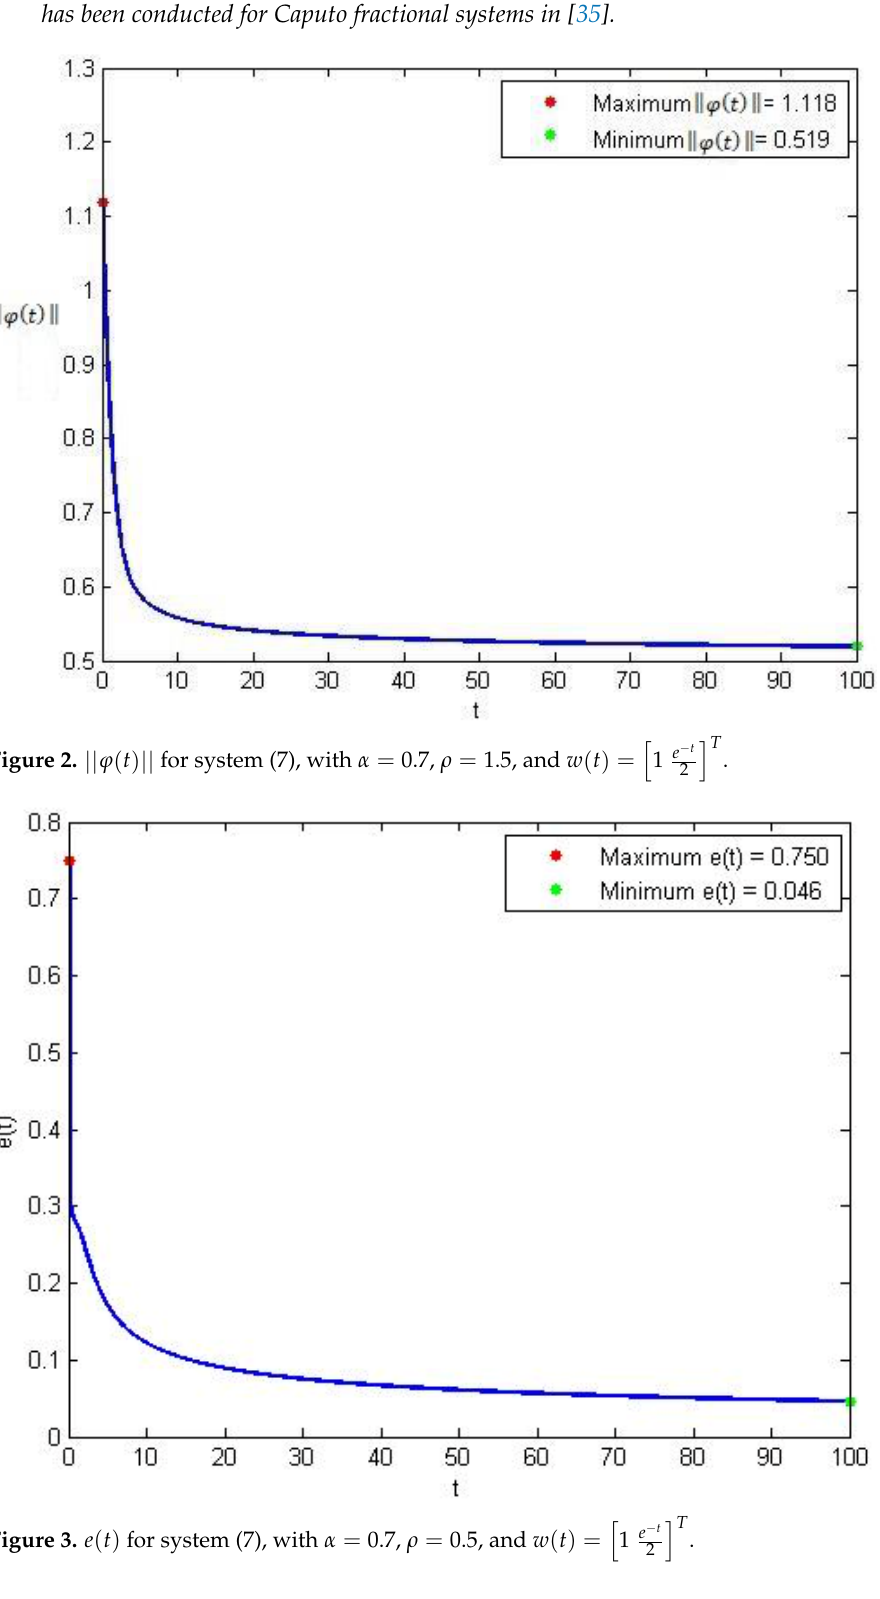
(cid:104) (cid:105) T −𝑡 1 e − t −𝑡 ] 𝑇 . 2 ] 𝑇 . 2 2